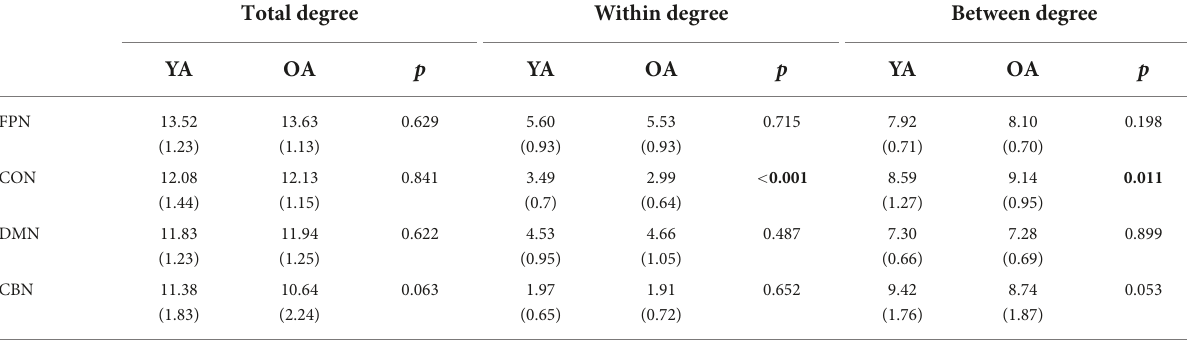
TABLE 6 Difference in network degree between young and older adolescents.